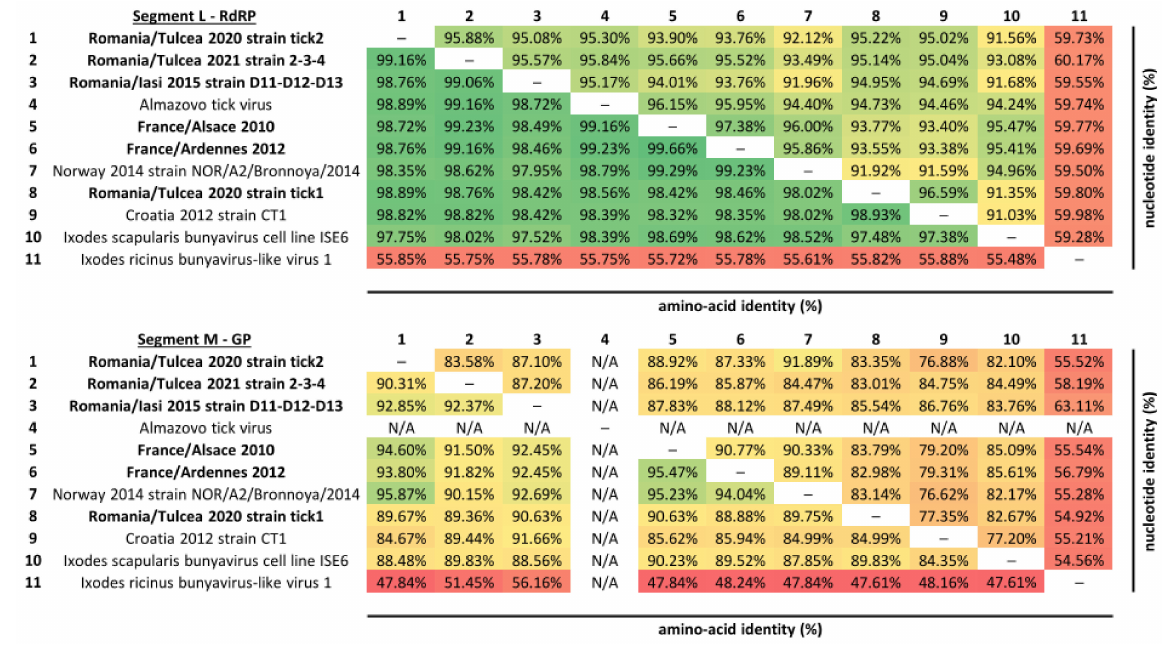
Figure 3. Amino-acid and nucleotide identity matrix of Bronnoya virus RNA-dependent RNA polymerase (upper panel) and glycoprotein (lower panel). Matrices were colored according to the identity scale: the lowest identities are represented in red and the highest in green. Sequences are ordered by similarity in the RdRP protein. “N/A” indicates that the glycoprotein sequence of the Almazovo tick virus is not available.